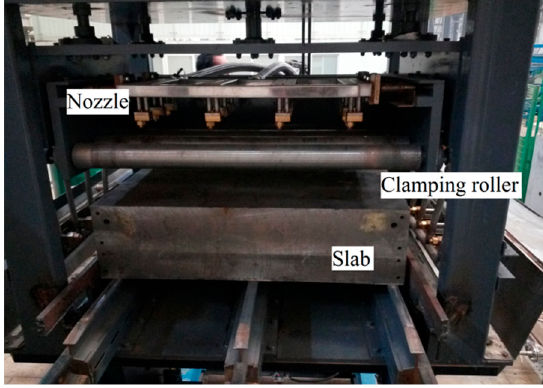
Figure 4. The clamping rollers with no contact slab.